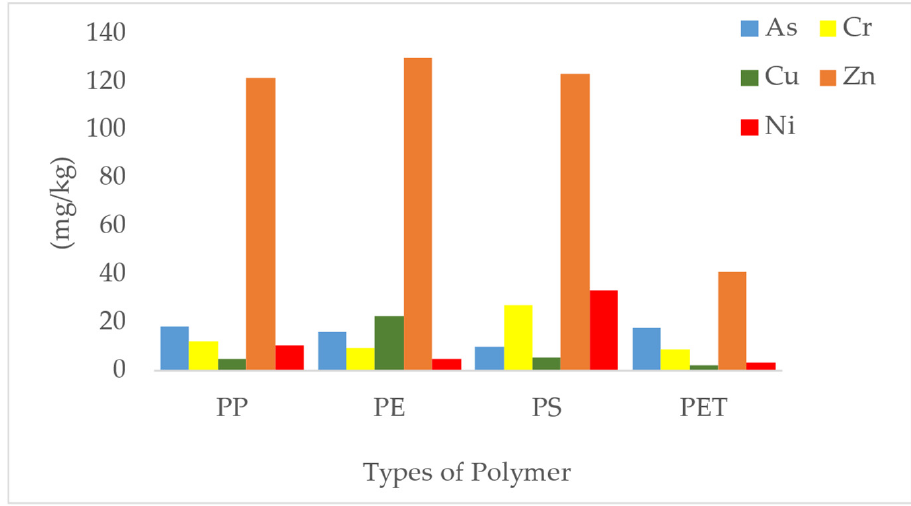
Figure 10. Concentrations of heavy metals in different types of polymers on Kebagu beach .